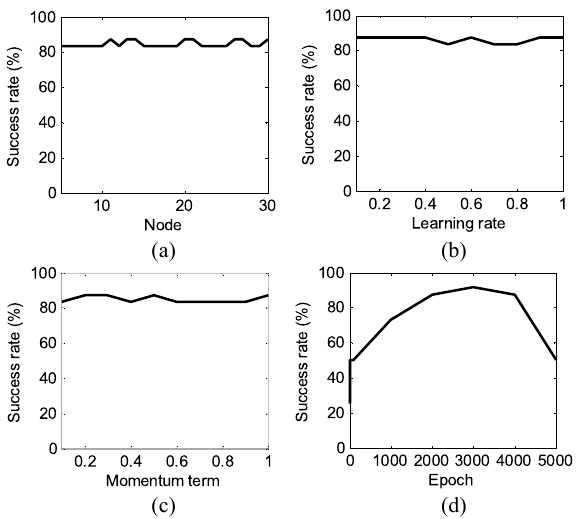
Fig. 11. The effects of the parameters in WNN on the success rate: (a) Node of WNN, (b) Momentum term, (c) Learning rate, and (d) Epoch. is necessary to optimize the parameters in WNN structure, including the number of nodes of the hidden layer, momentum factor, learning rate. Figure 11 shows effects of the four important parameters on the average success rate of the classification under four gear conditions in gearbox. Figure 11(a) shows the relation between number